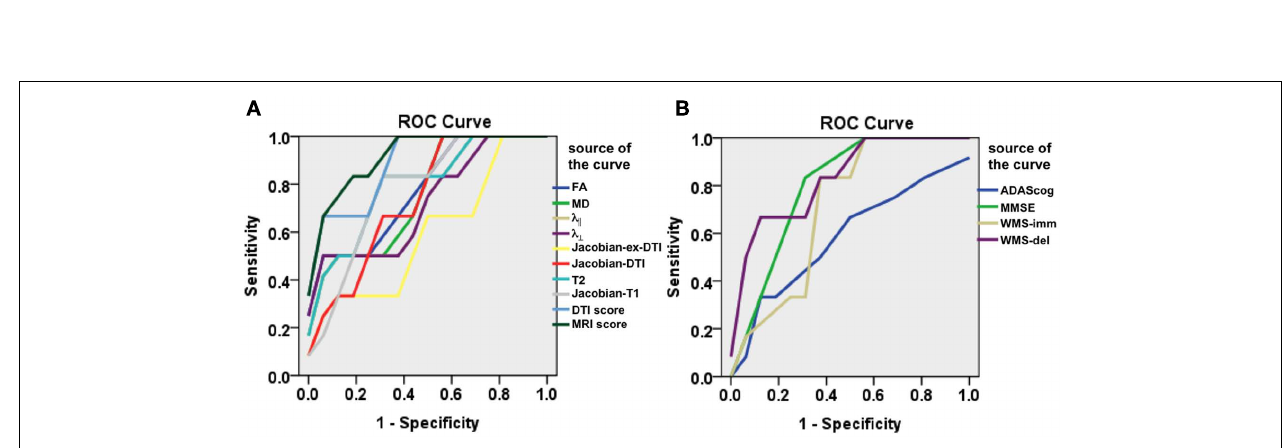
FIGURE 5 | Results of the receiver operating characteristic curve (ROC) analyses. (A) The ROCs of various MR measurements. (B) The ROCs of various cognitive tests.WMS-imm: number of correct answers in the immediate story recall of theWMS-III;WMS-del: number of correct answers in the delayed story recall of